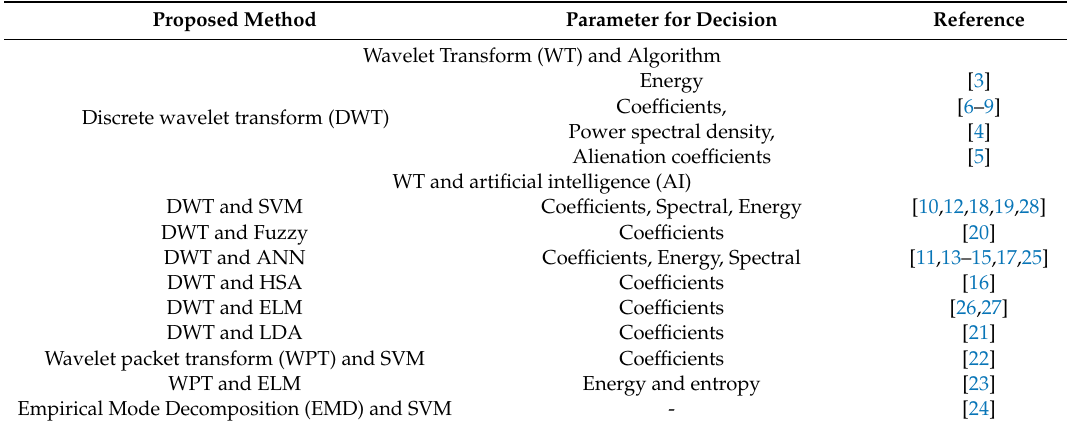
Table 1. Fault detection and classification method of past